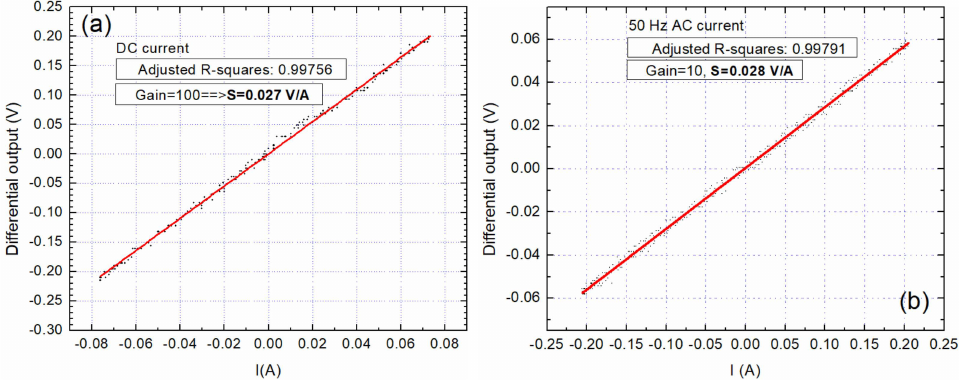
Figure 17. Di ff erential output of sensors polarized at 8 Oe: ( a ) DC, 75 mA, ( b ) AC, 200